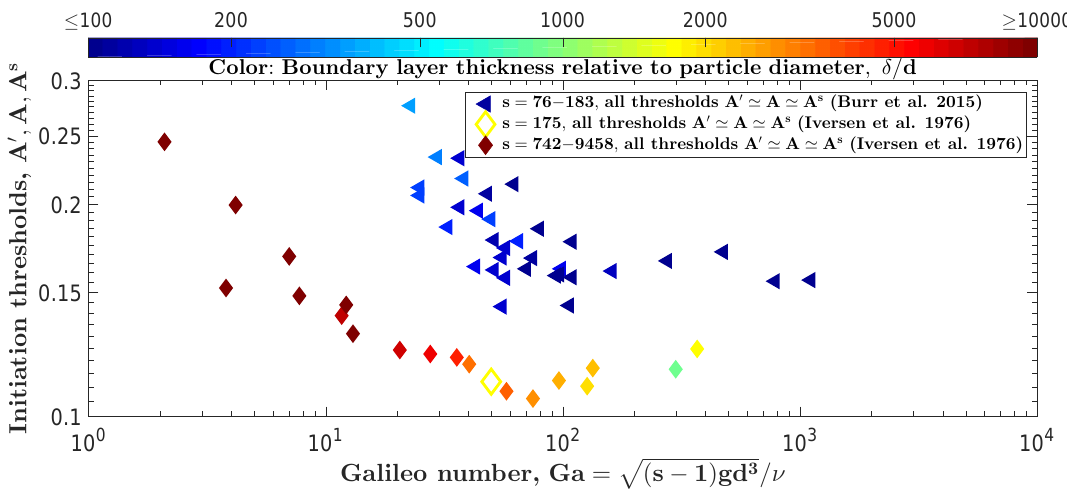
Figure 4. Measurements of the rocking ( A (cid:48) ), rolling ( A ), and saltation ( A s ) threshold parameters versus the Galileo number Ga. Only those conditions from Figure 2 that obey A (cid:48) (cid:39) A (cid:39) A s [15,53] are shown. The color indicates the the thickness of the boundary layer δ relative to the particle diameter d (different from Figure 2), which controls the relative amplitude of turbulent fluid velocity fluctuations for a constant